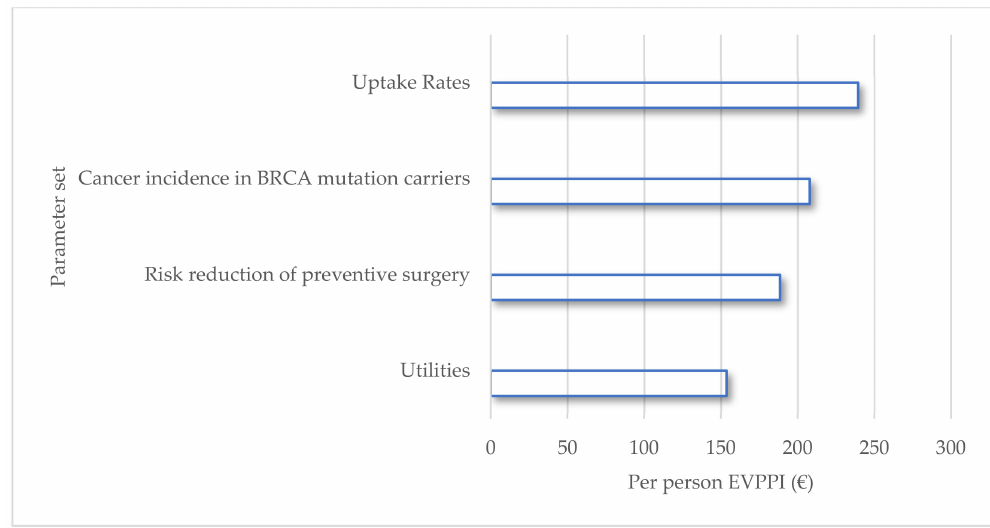
Figure 3. Expected value of partial perfect information (EVPPI) for parameter